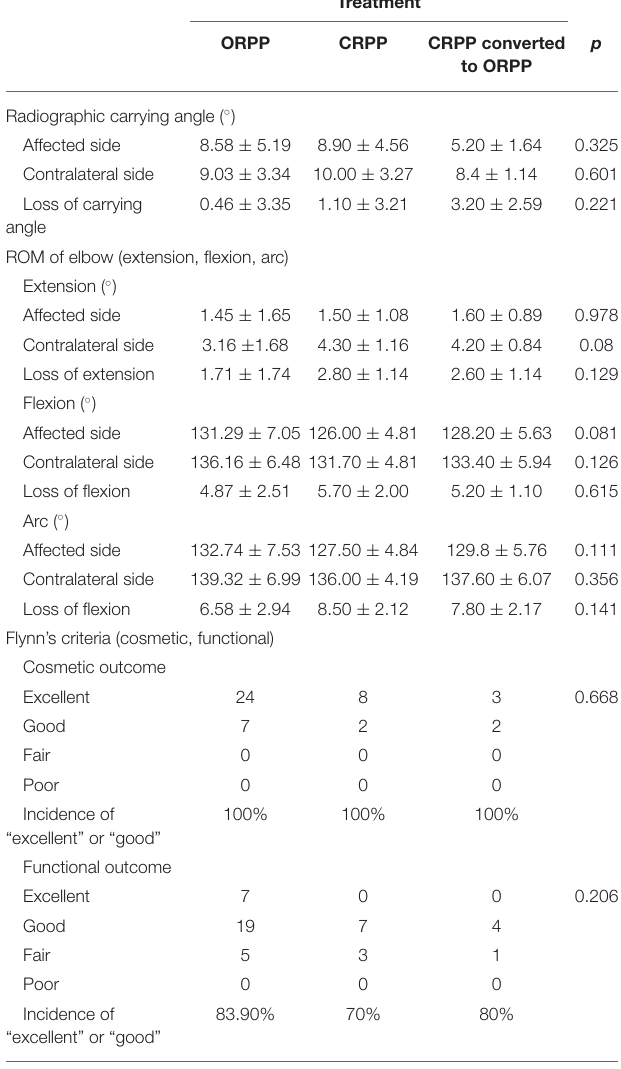
TABLE 2 | Complications in three groups. TABLE 3 | Radiographic and clinical outcomes of three groups.